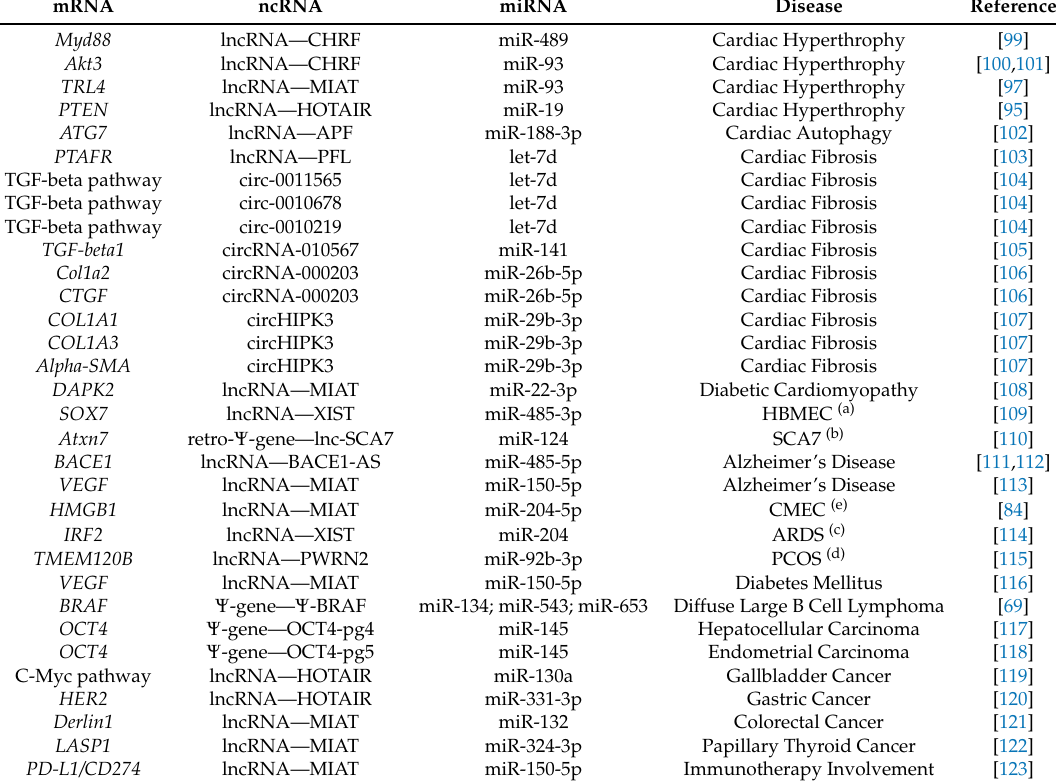
Table 1. Table summarizing the miRNA-ceRNAs networks discussed in the review. Table fields are: mRNA, protein coding genes name; ncRNA, non-coding RNAs class and name; miRNA, microRNA involved; Disease; Reference. (a) HBMEC, Human Brain Microvascular Endothelial Cells; (b) SCA7, Spinocerebellar Ataxia Type 7; (c) ARDS, Acute Respiratory Distress Syndrome; (d) PCOS, Polycystic Ovary Syndrome; (e) CMEC, Cerebral Microvascular Endothelial Cell